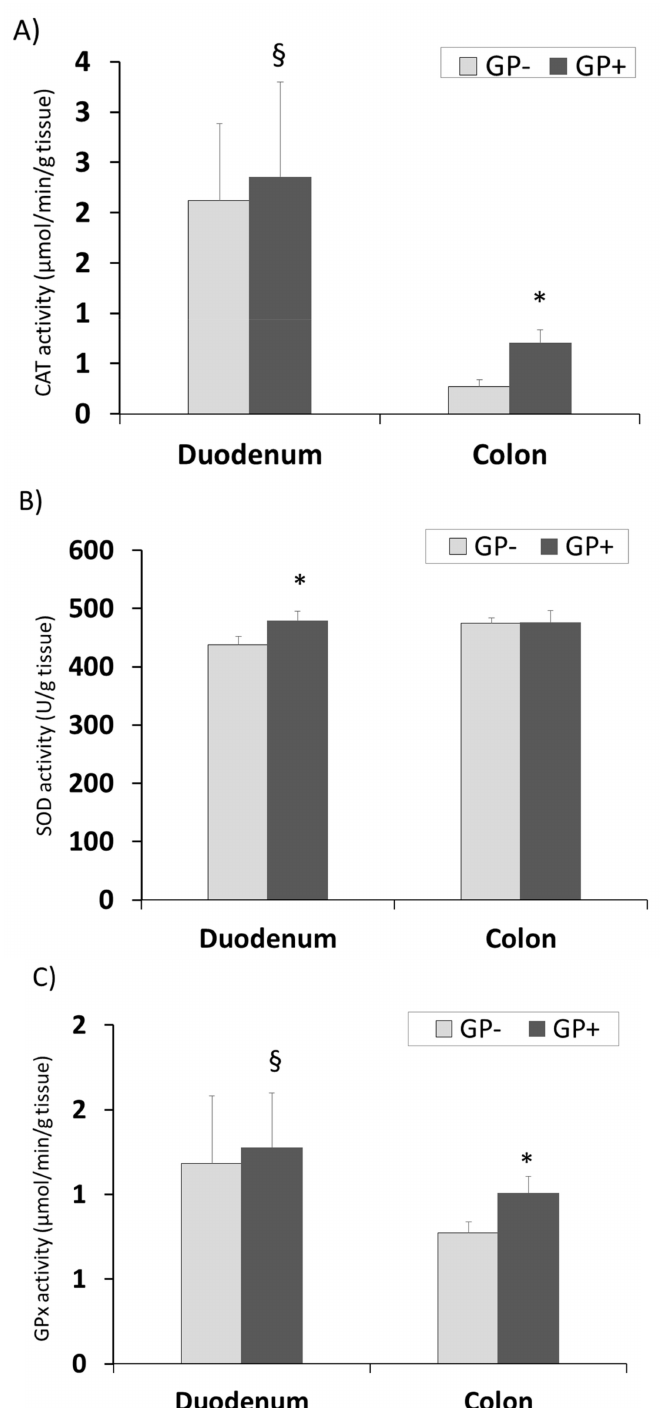
Figure 7. Antioxidant activity in duodenum and colon samples (n = 10) as determined by: catalase (CAT) activity ( µ mol/min/g tissue) ( A ), superoxide dismutase (SOD) activity (U/g tissue) ( B ),glutathione peroxidase (GPx) activity ( µ mol/min/g tissue) ( C ); * = statistically significant when GP − was compared with GP+, § = statistically significant when compared with colon